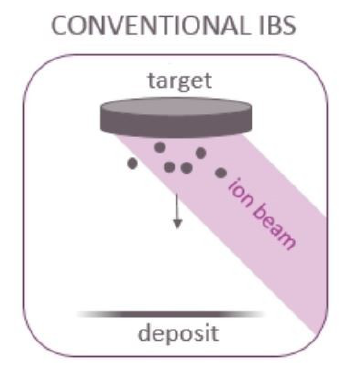
Fig. 5. The 3 kW thermal electron beam facility